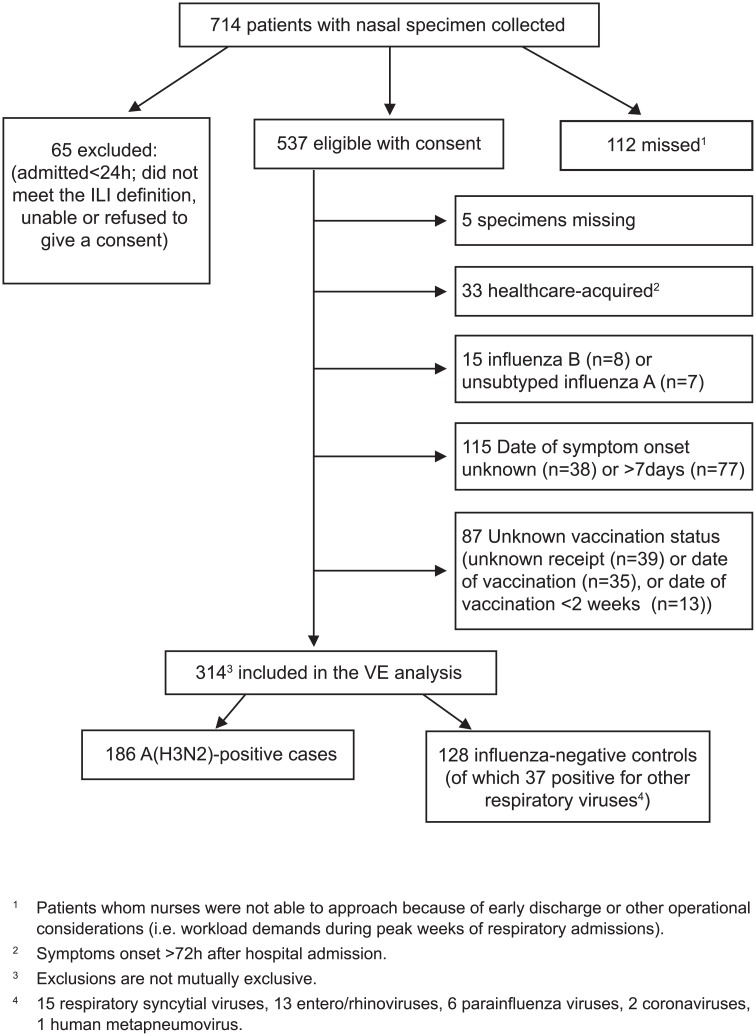
Specimen inclusion/exclusion criteria for primary vaccine effectiveness analysis.
1Patients whom nurses were not able to approach because of early discharge or other operational considerations (i.e. workload demands during peak weeks of respiratory admissions); 2Symptoms onset >72h after hospital admission; 3Exclusions are not mutually exclusive; 415 respiratory syncytial viruses, 13 entero/rhinoviruses, 6 parainfluenza viruses, 2 coronaviruses, 1 human metapneumovirus